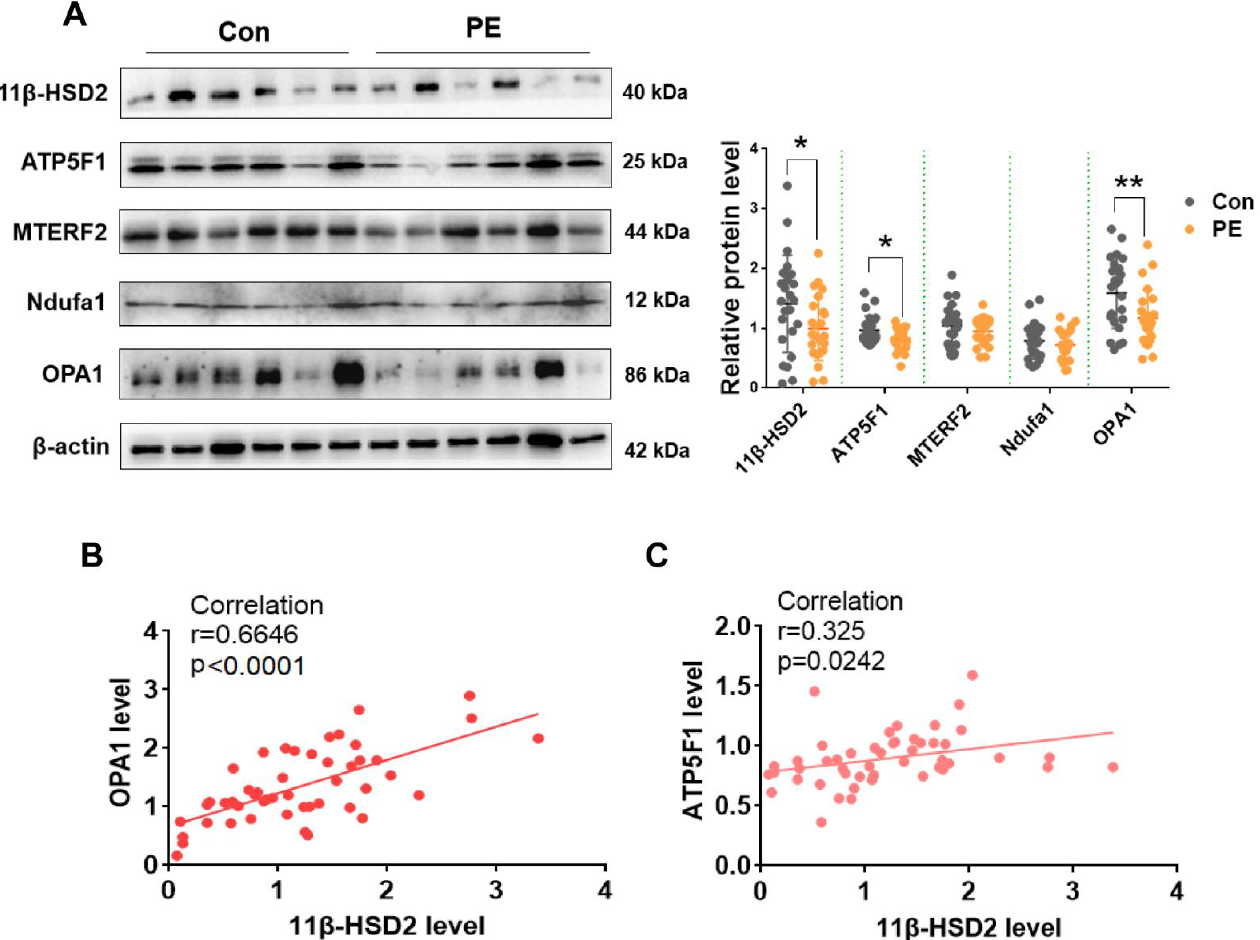
Figure 8. The correlation analysis of 11β -HSD2 level with OPA1, MTERF2, Ndufa1 and ATP5F1 levels in placentas of PE patients. ( A ) the expression levels of 11β -HSD2, OPA1, MTERF2, Ndufa1 and ATP5F1 in normotension (Con) and PE placentas. Left panel : representative images of Western blotting. Right panel : cumulative data of each protein expression level. ( B ) correlation analysis of grayscale value between 11β -HSD2 and OPA1. ( C ) correlation analysis of grayscale value between11β -HSD2 and ATP5F1. n = 24 in each group. * p < 0.05, ** p < 0.01.